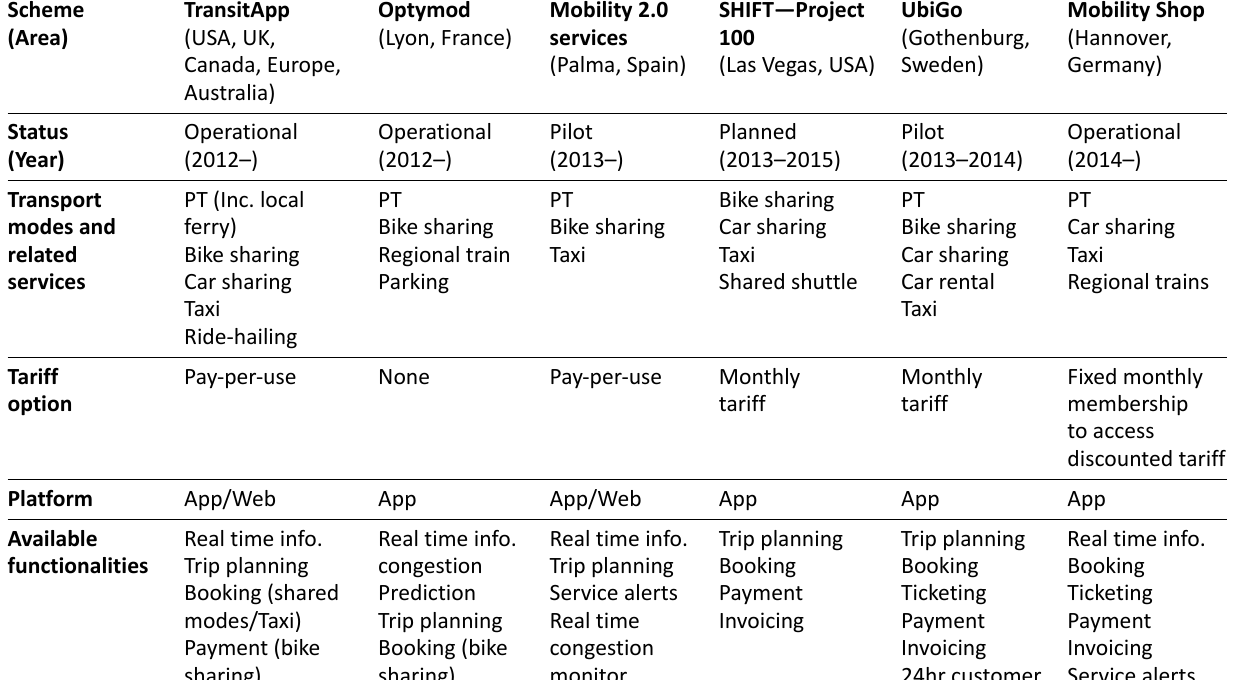
Table 2. Summary of MaaS schemes reviewed in this study.